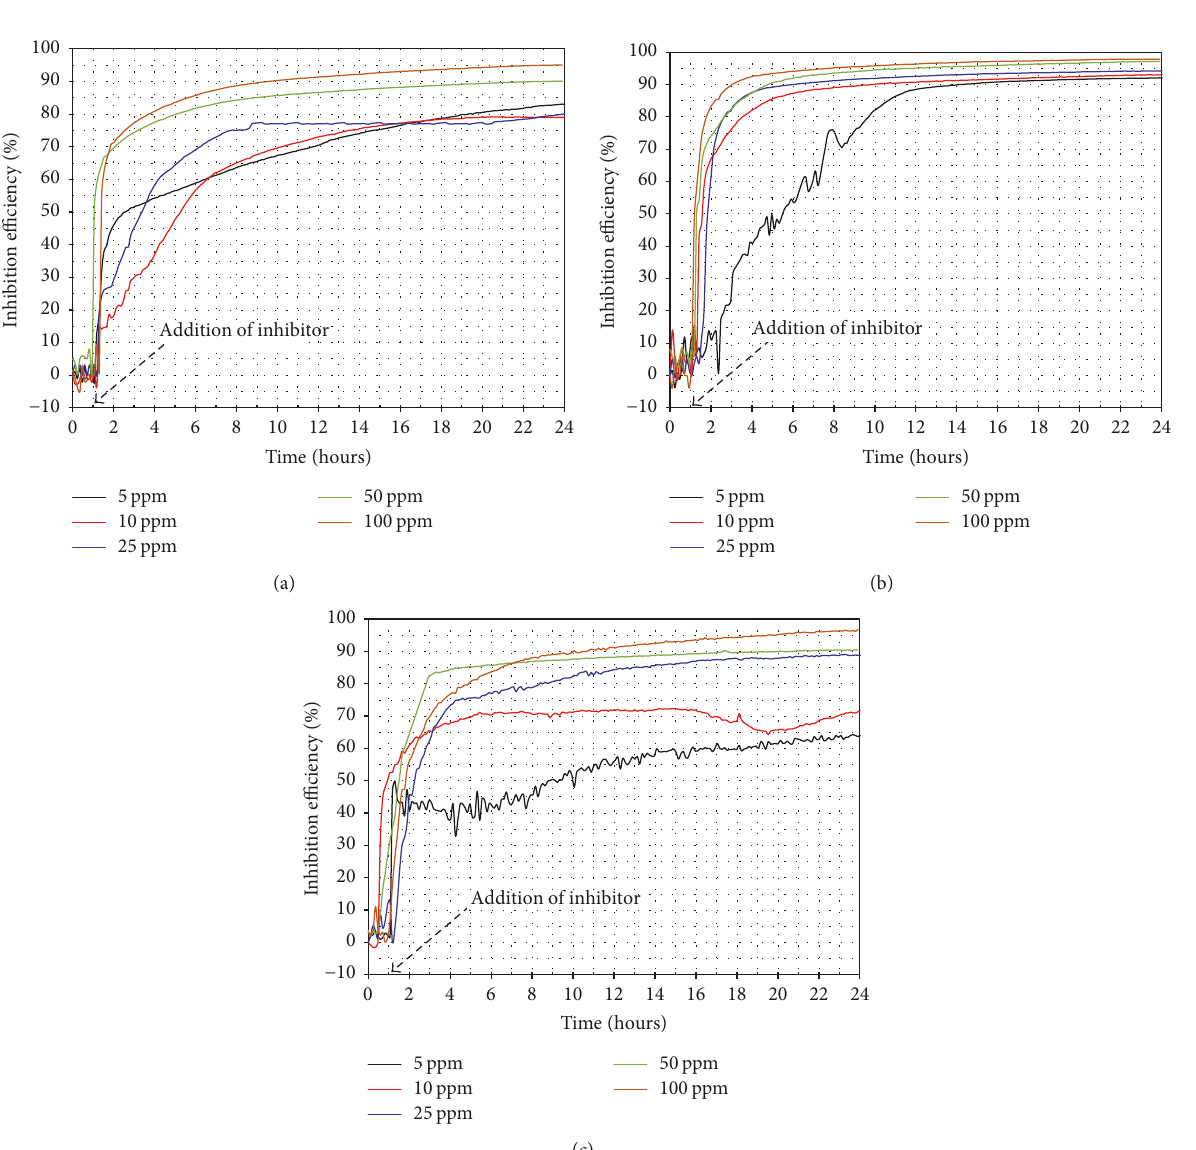
Figure 3: Variation of the inhibition efficiency determined from RPL measurements (real-time monitoring): (a) 30 ∘ C, (b) 50 ∘ C, and (c) 70 ∘